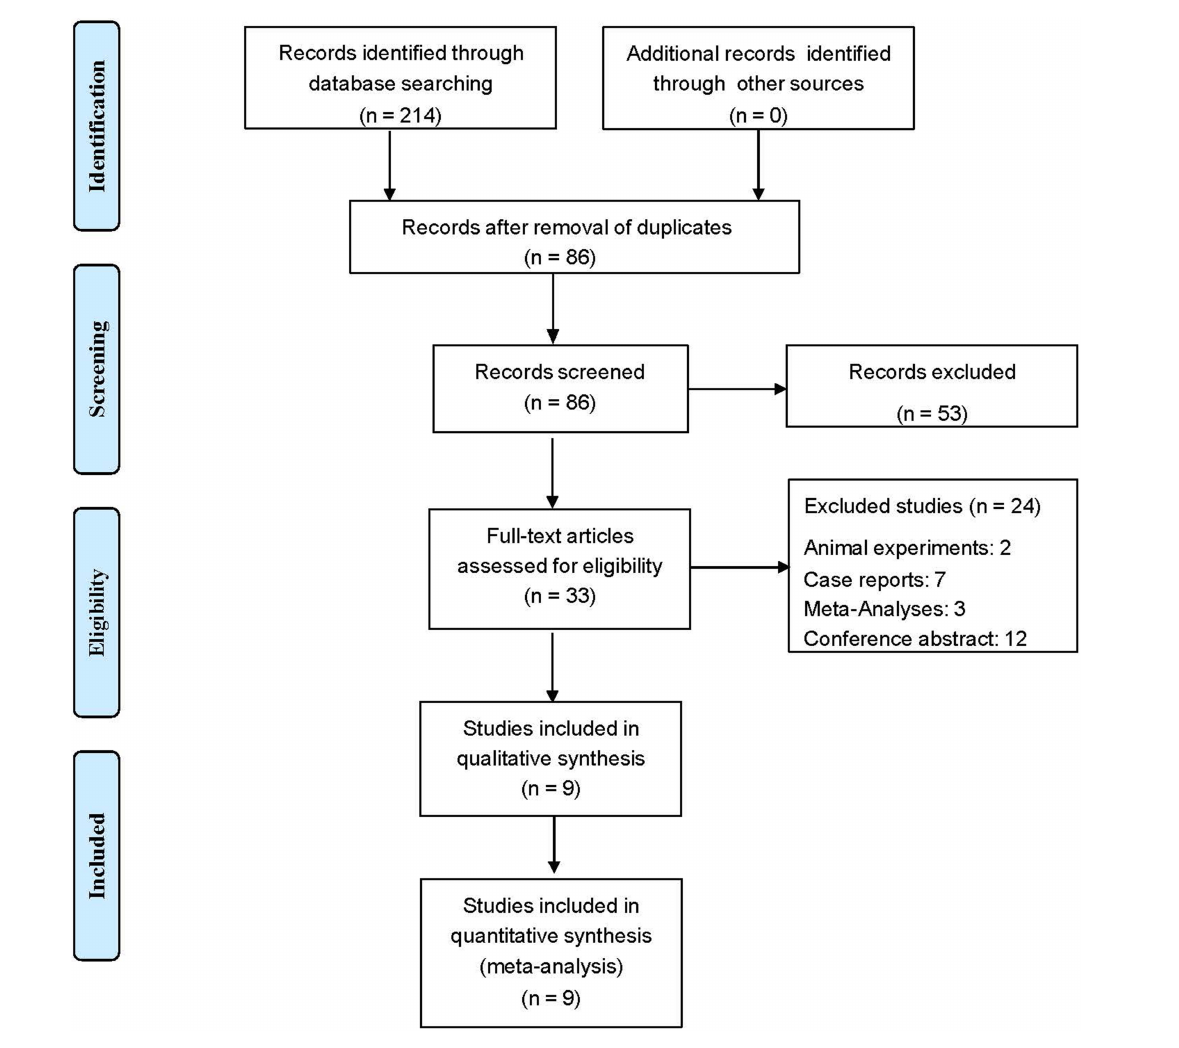
FIGURE1 The PRISMA